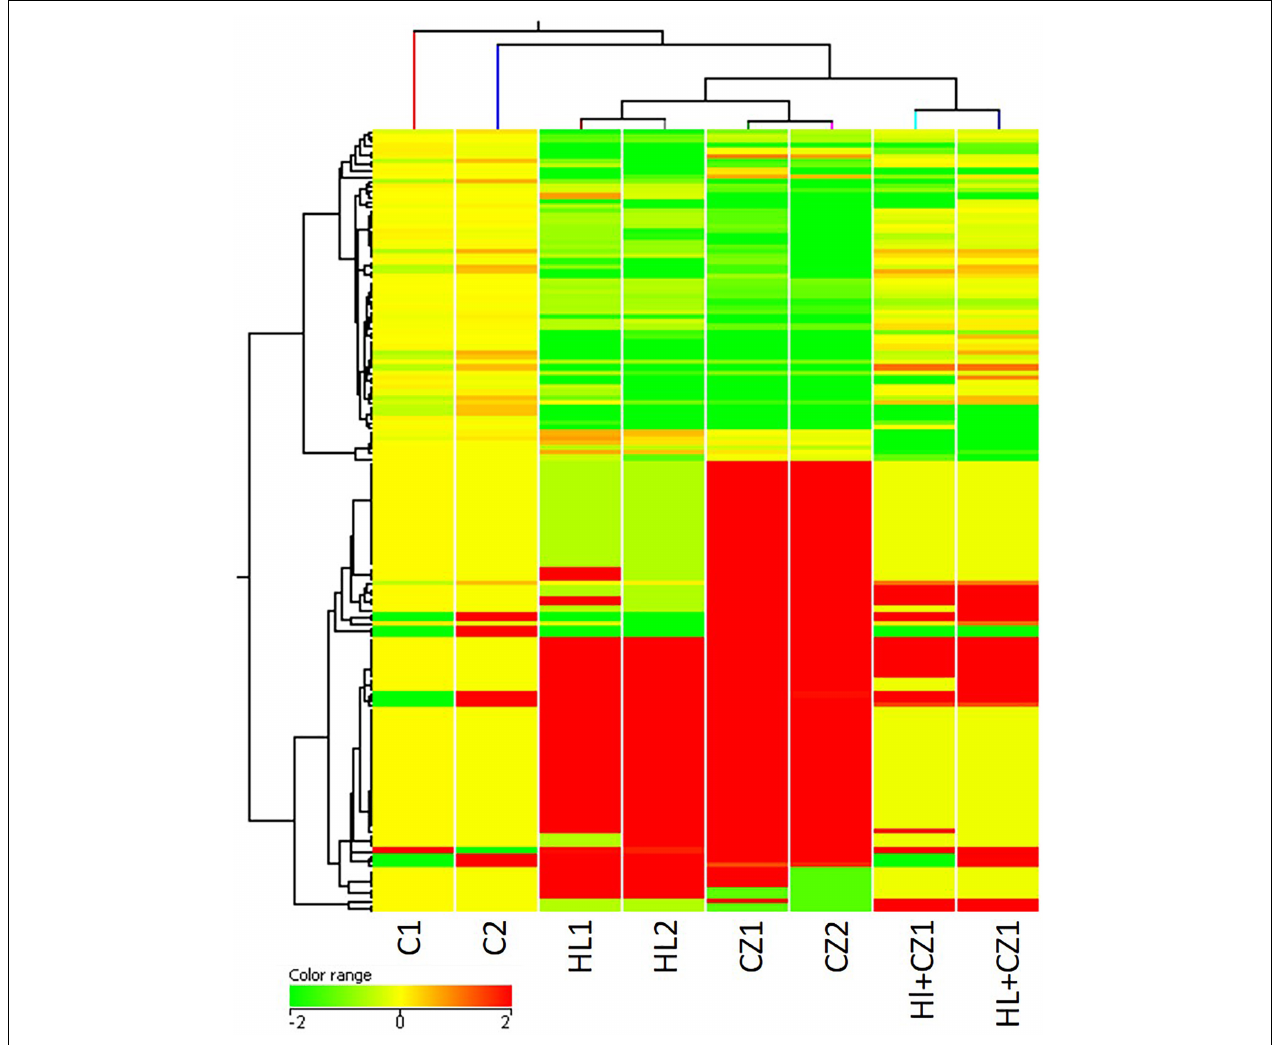
FIGURE 1 | Heat map showing altered microRNAs (miRNAs) in the different treatment groups (HL – haloperidol, CZ – clozapine, and HL + CZ) and control (C). The color range scale depicts the expression level of a miRNA across all samples. Red color represents expression above the mean, and green color represents expression lower than mean. Significant changes in expression levels from high to low and vice-versa can be seen as distinct blocks across samples for different miRNAs.